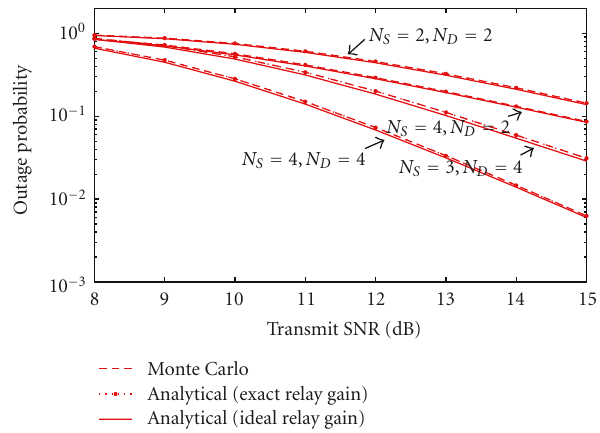
Figure 2: Outage probability of the system with di ff erent numbers of